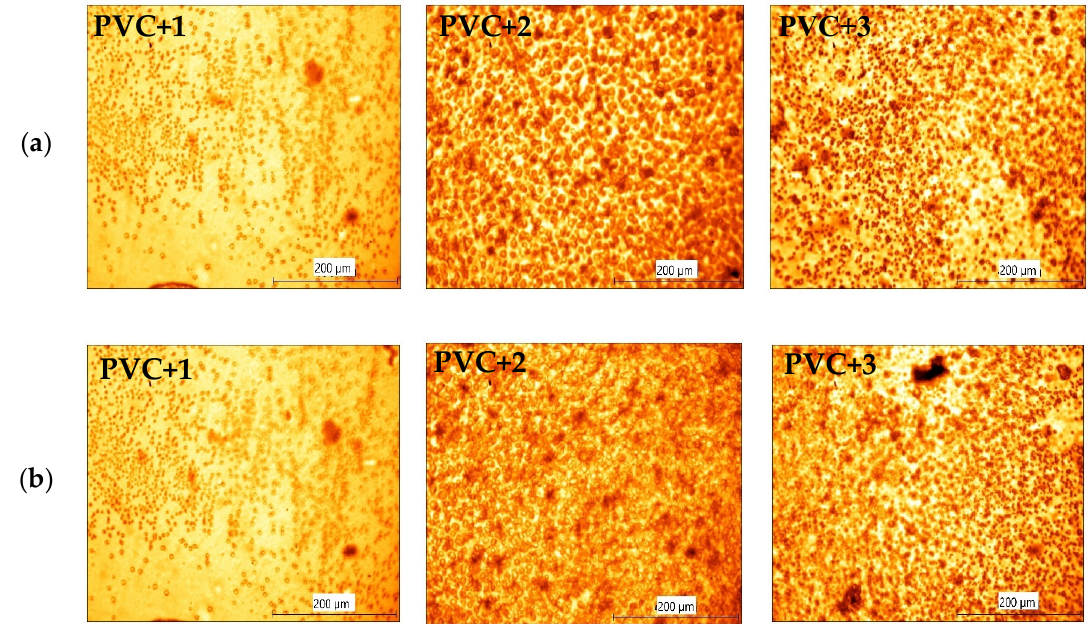
Figure 9. PVC surface microscopic images ( a ) before exposure to UV light, ( b ) after exposure to UV light (400× magnification).